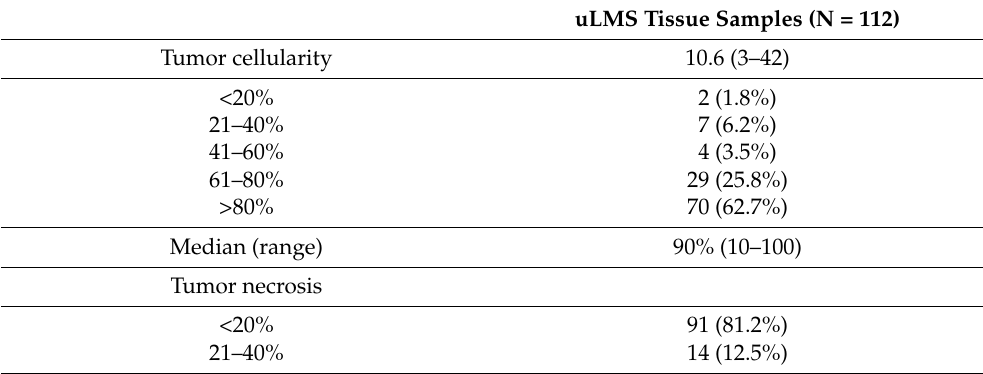
Table 2. Histology and immunohistochemistry features of uLMS tissue